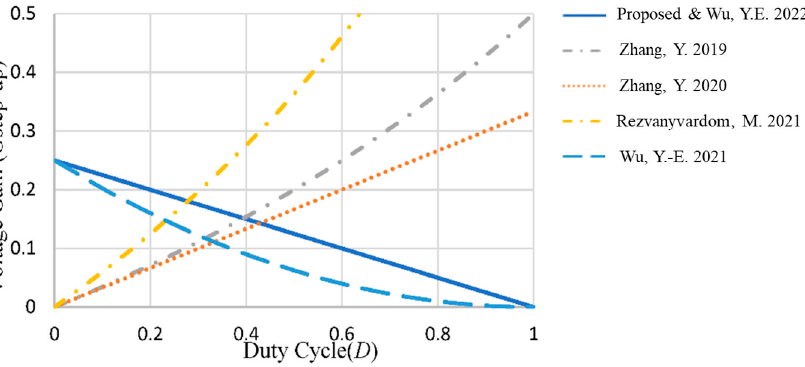
Figure 16. Voltage gain of the compared converters in the step-down mode.